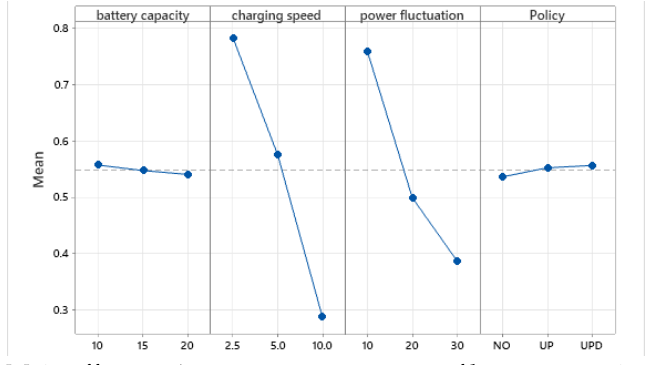
Figure 3. Graphs of the response mean for each factor level.